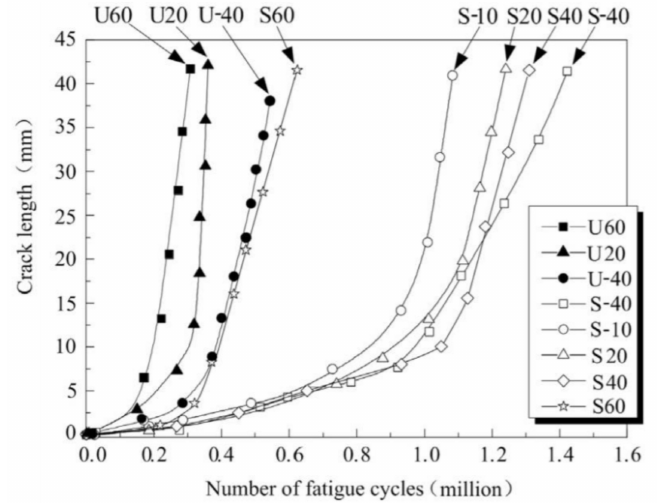
Figure 14. Crack propagation curves of unstrengthened, “U”, steel plates and strengthened steel plates, “S”, under temperature exposure [120]; used with permission from Thin-Walled Structures, Elsevier,